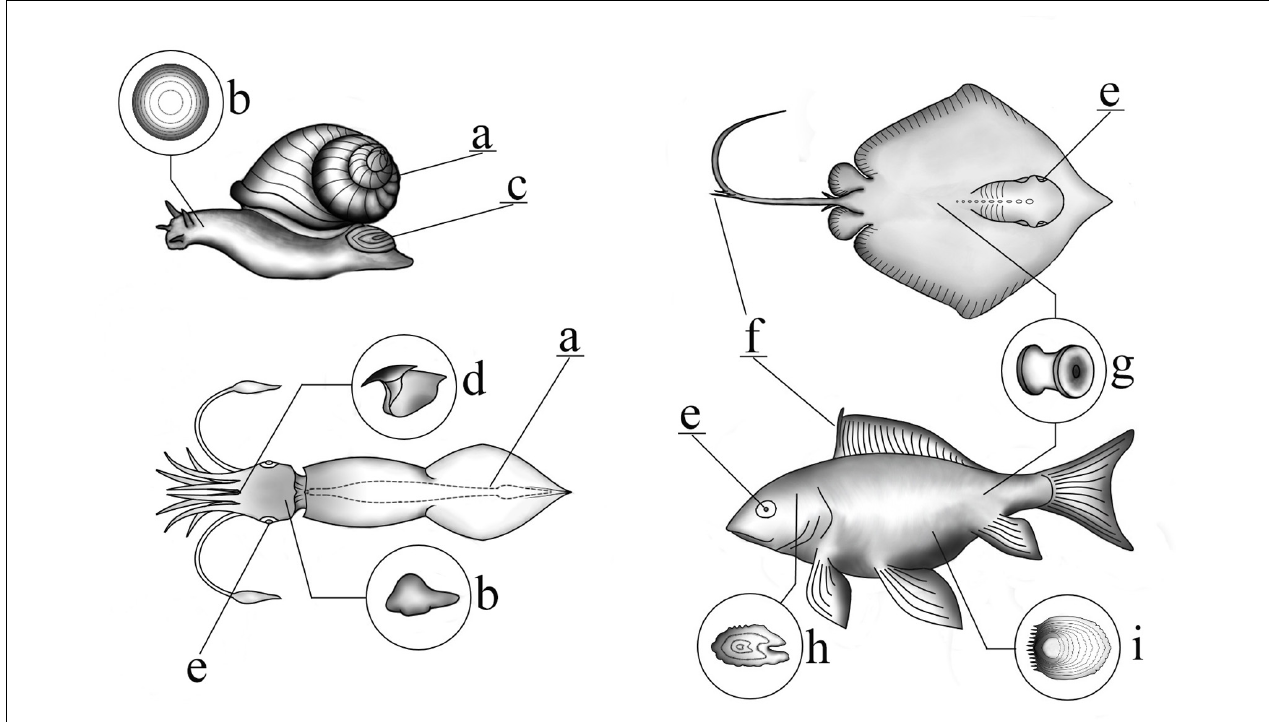
FIGURE 1 | Schematic illustrating the location of various recording structures in marine species. (a) Shell (may be internal or external), (b) statolith, (c) operculum, (d) beak, (e) eye lens, (f) fin ray/sting ray, (g) vertebrae, (h) otolith, (i)